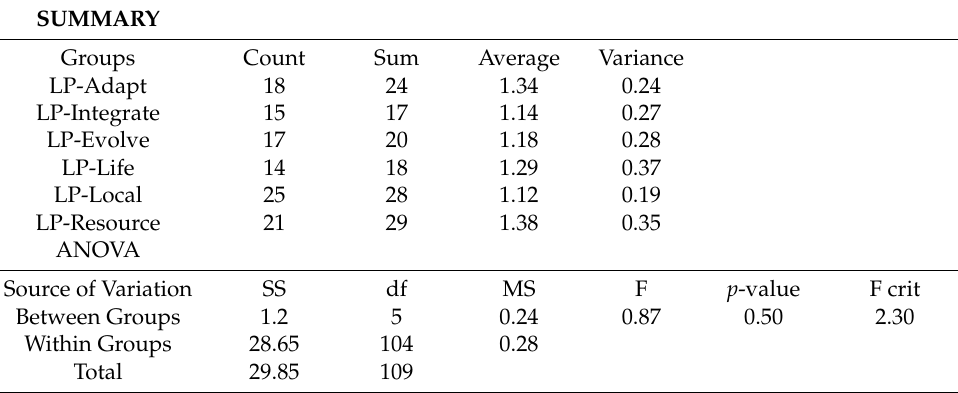
Table 4. Summary table single factor ANOVA for followed directions.